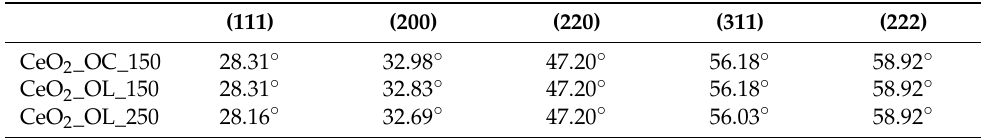
Table 3. Experimental values of the diffraction angles (2 θ , degs) and corresponding Miller indices (hkl) of diffraction peaks observed in the profiles reported in Figure